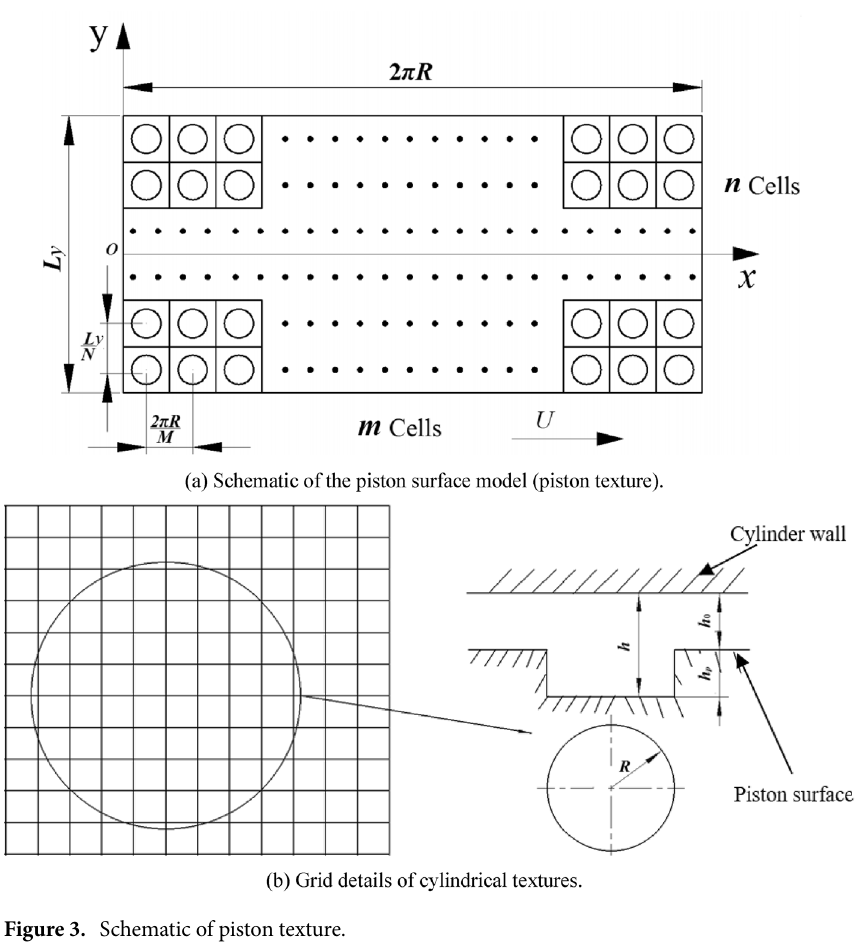
Figure 3. Schematic of piston texture.